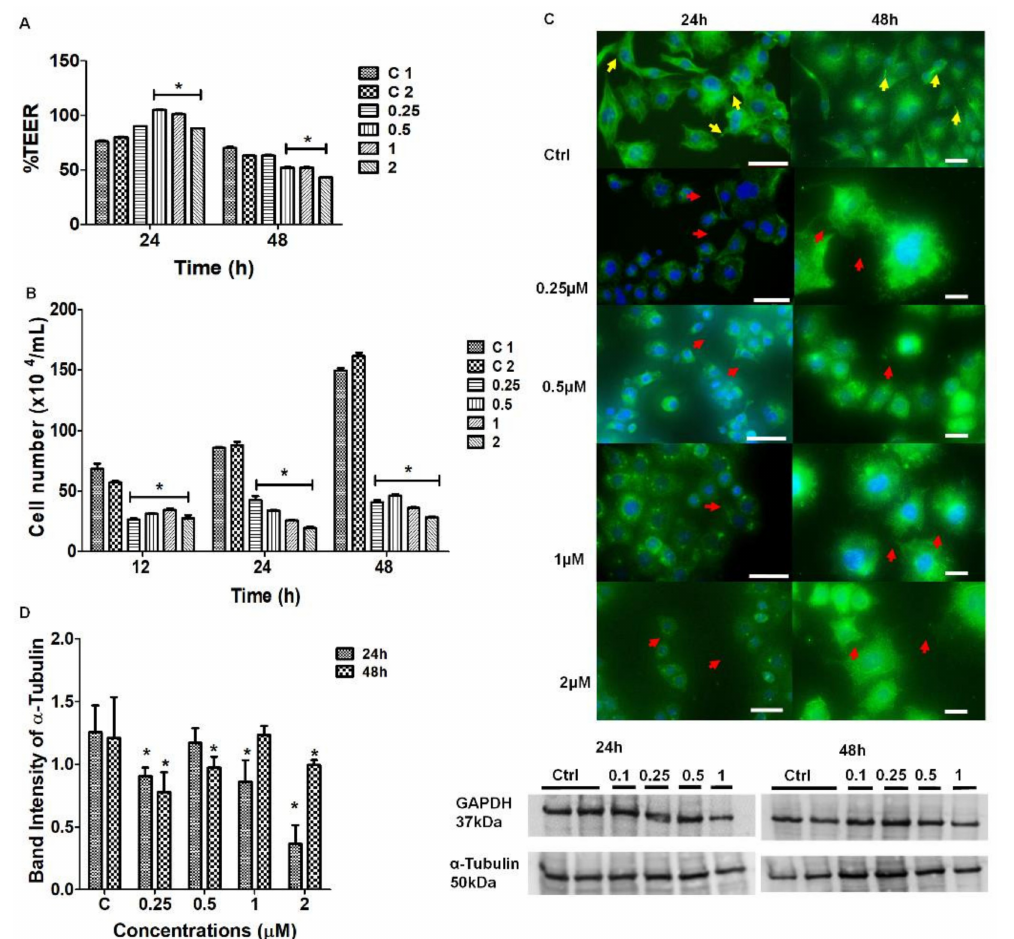
Figure 7. The effect of Nocodazole on the selected physiological parameters of bEnd5 cells. ( A ) The decreasing TEER across confluent bEnd5 cell monolayers upon treatment with 0.25–2 µ M Nocodazole. The single asterisk * represents significant differences between the experiments and the untreated (control) samples. The data are expressed as the mean ± SEM; ( B ) Represents the effect of Nocoda- zole on bEnd5 cell numbers. The asterisk * denotes statistically significant differences between the experimental samples relative to the untreated conditions (C1) and the vehicle control 2 (C2-with 0.1% DMSO); ( C ) IF micrographs of Alexa Fluor 488 conjugated, monoclonal α -tubulin Ab’ after 24–48 h Nocodazole treatment for 24 h (Scale bar = 50 µ M) and 48 h (Scale bar = 20 µ M). The yellow arrowheads indicate regions of intercellular NT formation and the red arrowheads indicate regions of depolymerization at the membrane leading edges between adjacent BECs; ( D ) The depolymerizing effect of Nocodazole on α -tubulin at 24 h and 48 h observed in the Western blot analysis, which showed significant suppression in protein expression relative to the controls for 24–48 h. The as- terisks * denotes statistically significant differences between the experimental samples and both control 1 and 2. The data are represented as the mean ± SEM ( n = 3). Statistical significance was determined at p -value <